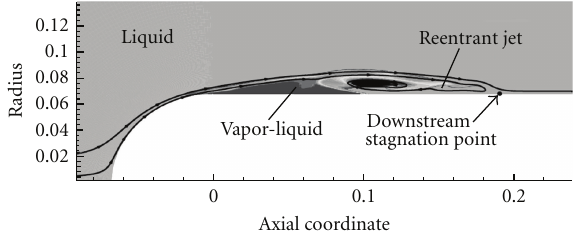
Figure 4: Vapour volume fraction and selected streamlines for cavitating flow around a hemispherical fore-body for σ = 0 . 3.